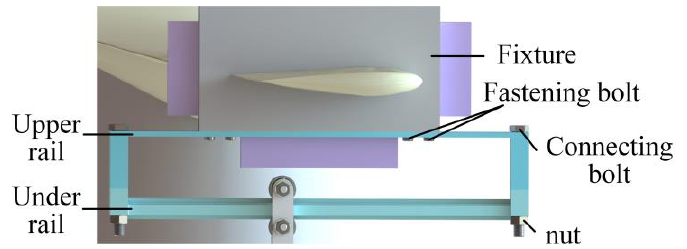
Figure 16. Top structure. Figure 16 Top structure. Figure 16 Top structure. Figure 16 Top structure.